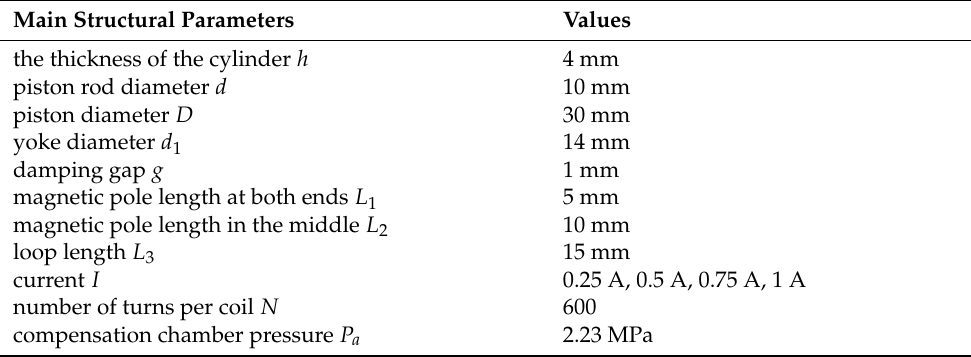
Table 2. Main design parameters and initial values of the